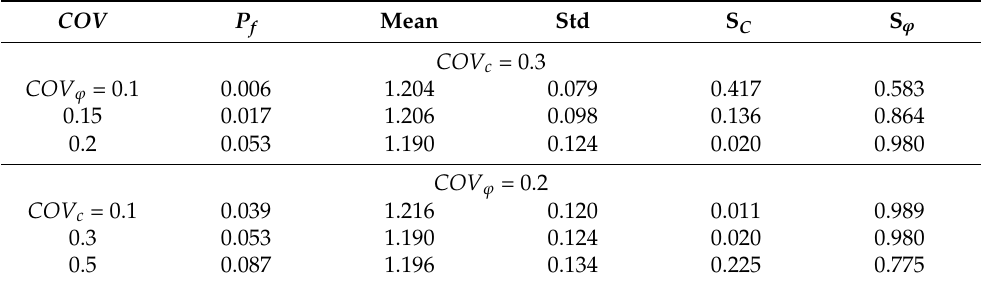
Table 7. Probabilistic results comparison with different values of coefficient of variation. COV P f Mean Std S C S ϕ COV c = 0.3 COV ϕ = 0.1